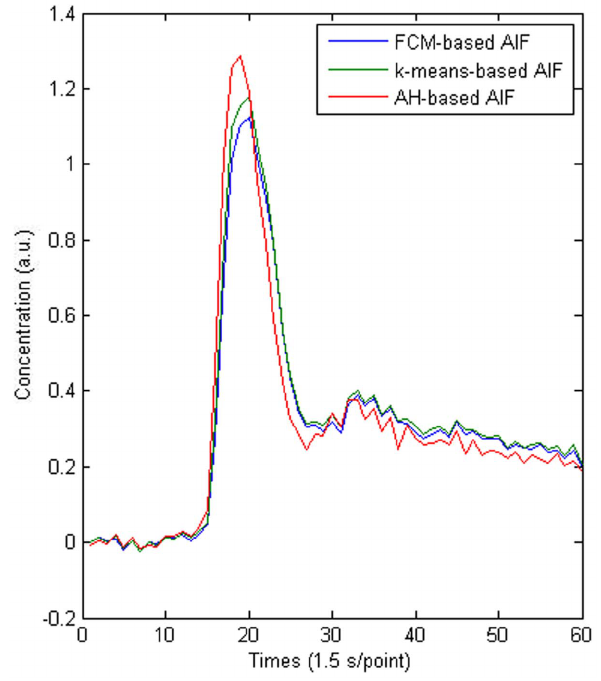
Figure 4. Comparison of the AIFs obtained using k -means, FCM, and AH clustering methods.